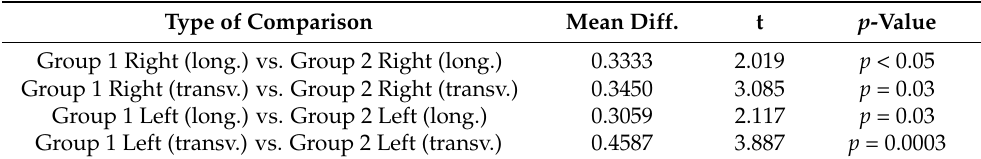
Table 4. Ultrasound measurements comparison between group 1 and group 2. Only statistically significant differences are reported. Type of Comparison Mean Diff. t p -Value Group 1 Right (long.) vs. Group 2 Right (long.) Group 1 Right (transv.) vs. Group 2 Right (transv.) Group 1 Left (long.) vs. Group 2 Left (long.) Group 1 Left (transv.) vs. Group 2 Left (transv.)